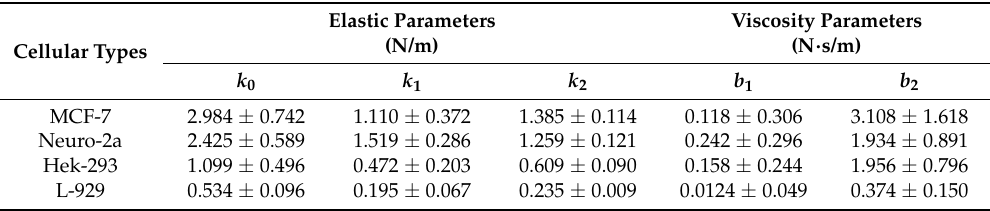
Table 1. Average parameters of cell four types.